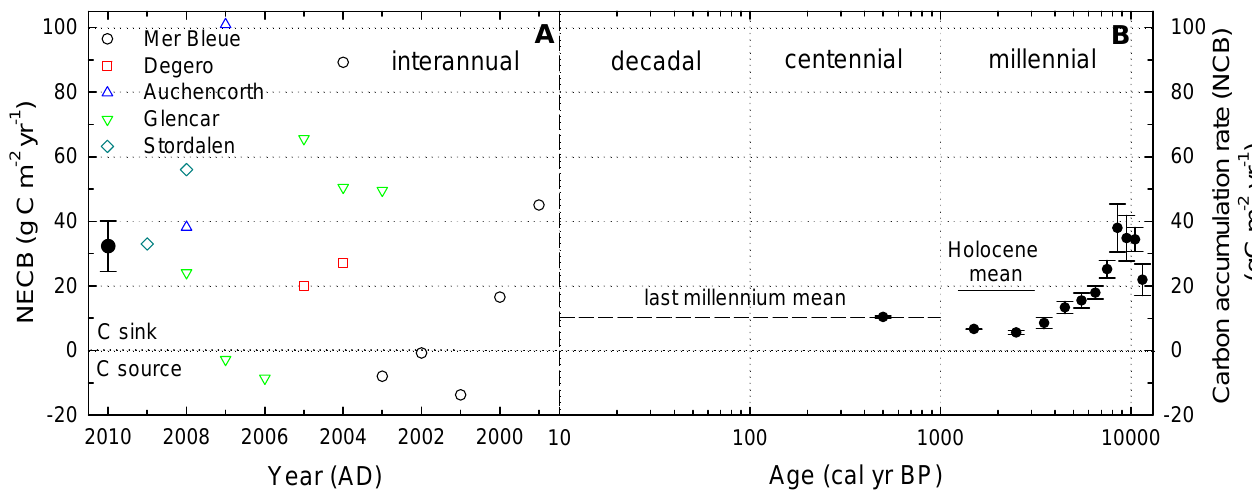
Fig. 3. Net ecosystem carbon balance across time scales in northern peatlands. (A) Net ecosystem carbon balance (NECB) from 5 peatland sites with a total of 18yr of measurements over the last decade (see Table 4 for details; Mer Bleue: Roulet et al., 2007; Deger¨o: Nilsson et al., 2008; Auchencorth: Dinsmore et al., 2010; Glencar: Koehler et al., 2011; Stordalen: Olefeldt et al. 2012); (B) peat-core derived net carbon balance (NCB) during the Holocene plotted on log scale to emphasize the different time scales (millennial, centennial and decadal), on the basis of 33 accumulation records (Fig. 1c; Yu et al., 2009) and 1516 basal ages (Fig. 1a; MacDonald et al.,